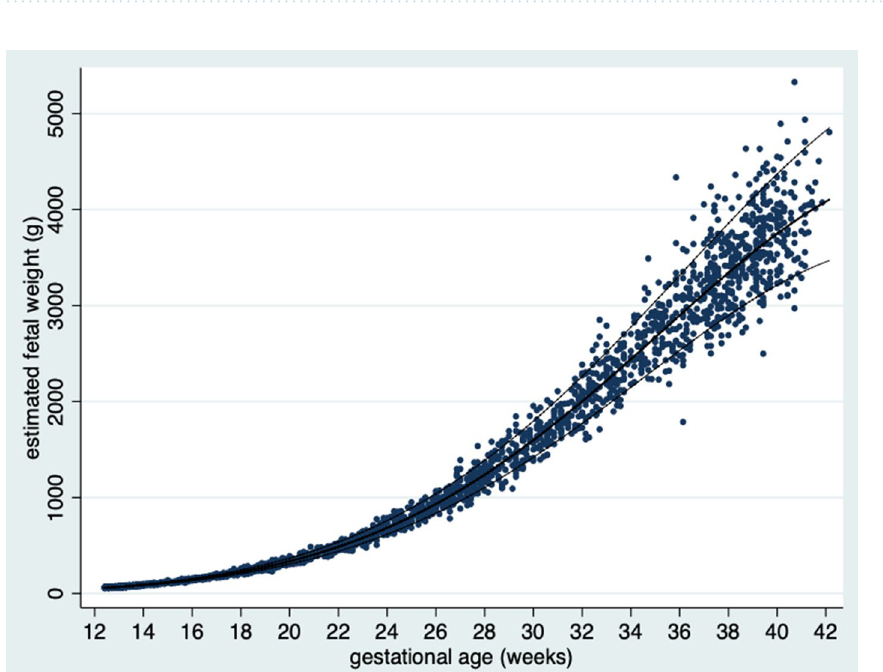
Figure 5. Raw data (n = 2551) with fitted percentiles (10th, 50th, 90th) for estimated fetal weight by gestational